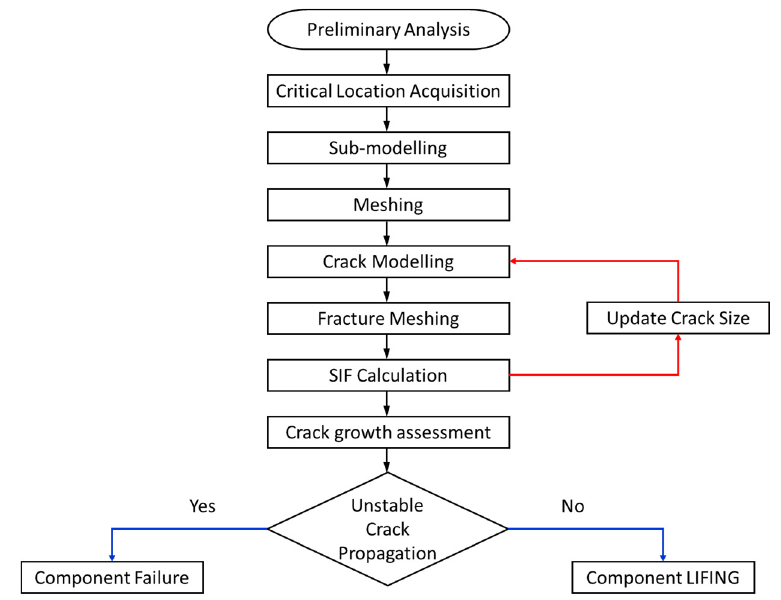
Figure 1. Flowchart of the whole crack growth procedure on the studied component.